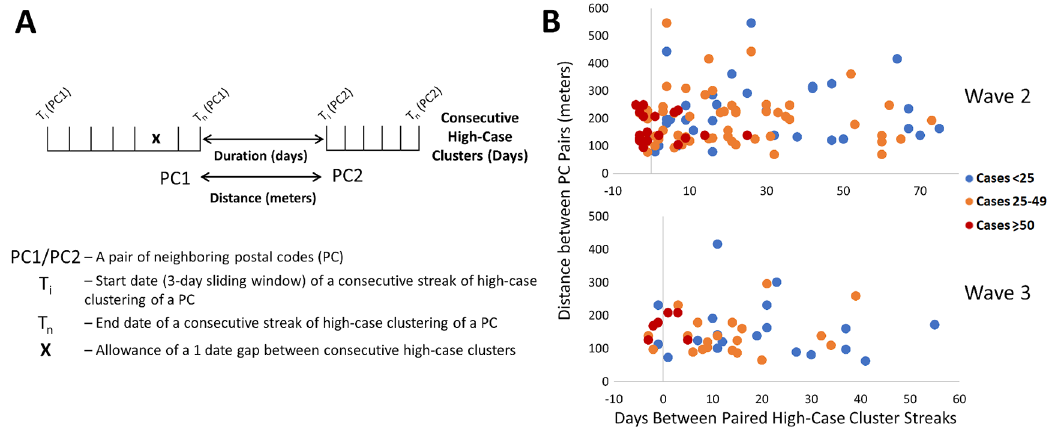
Figure 7. Contiguous or consecutive pairs of Toronto postal codes with COVID-19 case clusters lasting multipledays. PairsofneighboringPCswithhigh-casecountclusterswereidentifiedbyClusterandOutlieranalysis. Panels show: (A) parameters measured in PC pairs that were elements of significant high-case clusters over multiple consecutivedays(allowingforasingledaygap),termed “ streaks ” ;(B)characteristicsofneighboringpairsofPCswith multi-day streaks in close proximity in Toronto (of ten closest neighbors based on distance between centroids) during waves 2 (top) and 3 (bottom). Wave 1 is not indicated because streaks were infrequent. Each point represents apairof PCs, withcolor codes (see legend) indicating ranges of totalnumber ofcasesin both, the Xaxisindicates the duration between PC pairs (with negative values representing number of days of overlap between end of first PC streak and beginning of the second), and the Y axis indicates spatial distance between PCs constituting the